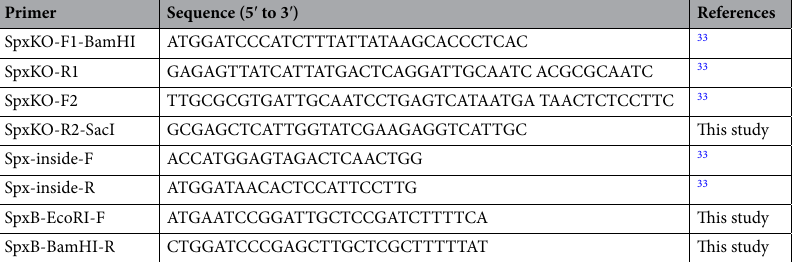
Table 1. Sequences of oligonucleotides used in